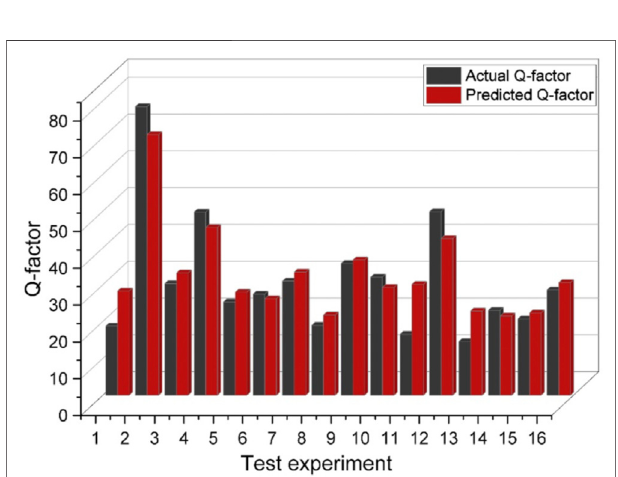
FIGURE 8 | The comparison of actual and predicted Q-factor values for different experiments.